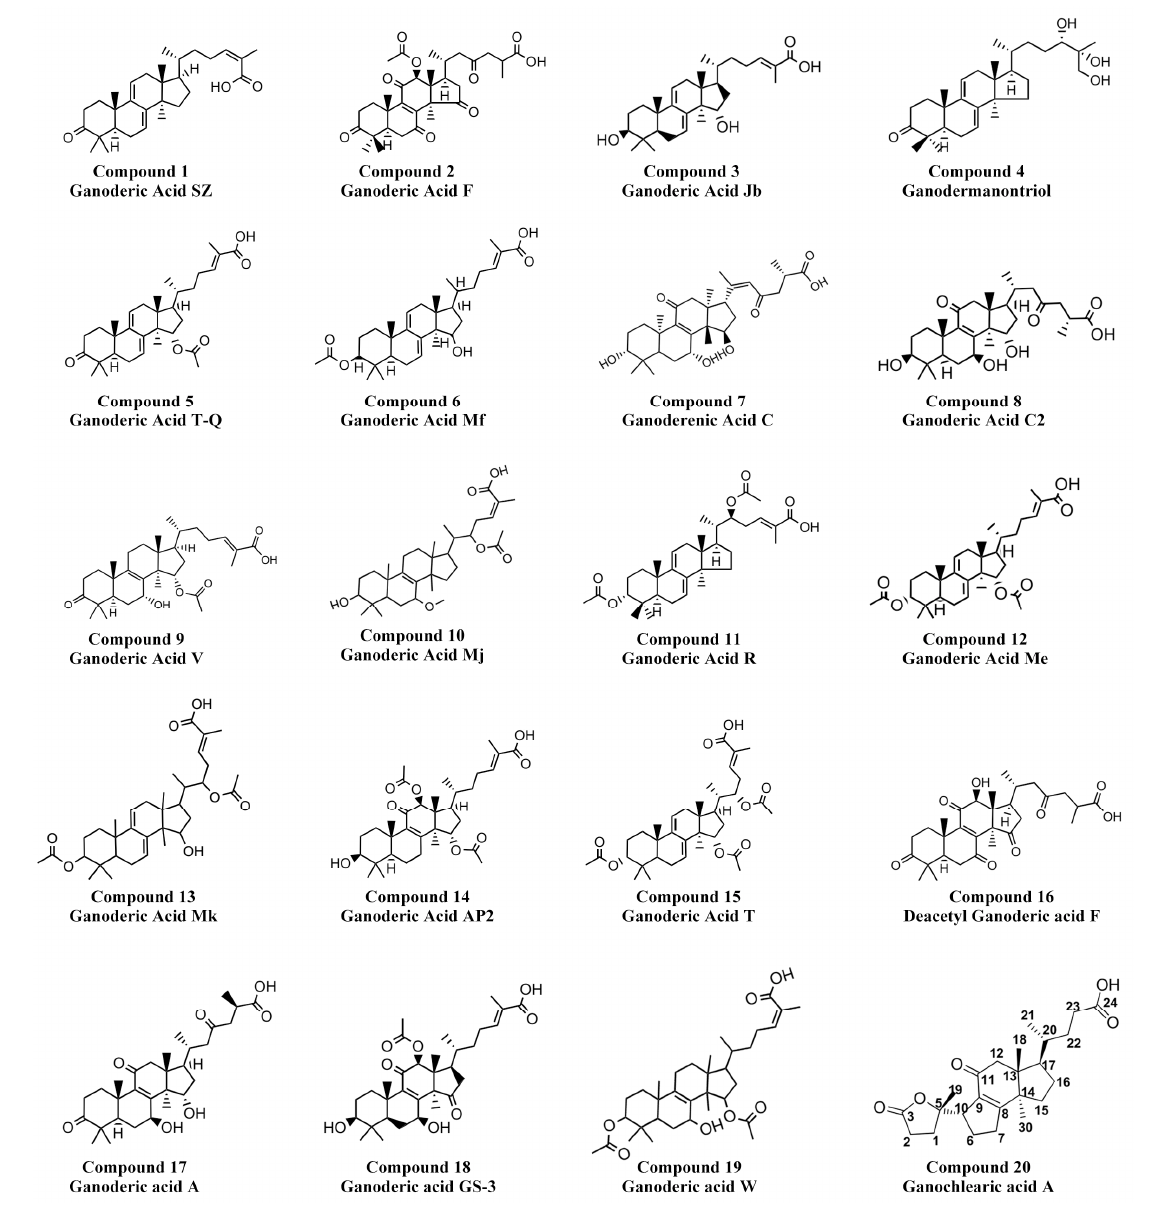
Figure 4. Chemical structures of the identified ganoderic acids. Table 2. Identification of possible ganoderic acids from G. lingzhi